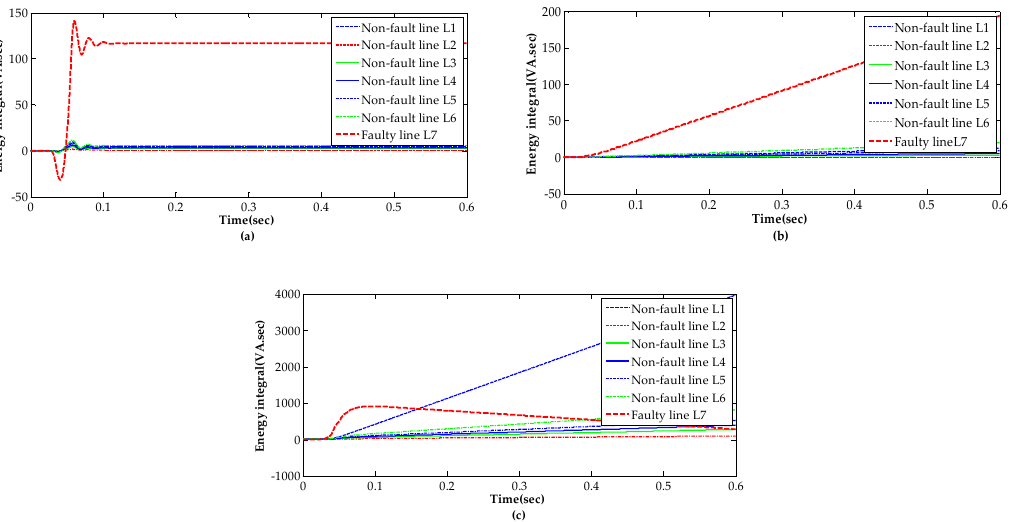
Figure 16. Comparison of the three energy integral under a SPG fault occurring on the line L 7 , at 8 km away from the bus, at 0 ◦ initial phase angle, with a resistance of 200 Ω . ( a ) The results of the energy integral scheme in this paper; ( b ) The results of the energy integral scheme in [20]; ( c ) The results of the energy integral scheme in [21].